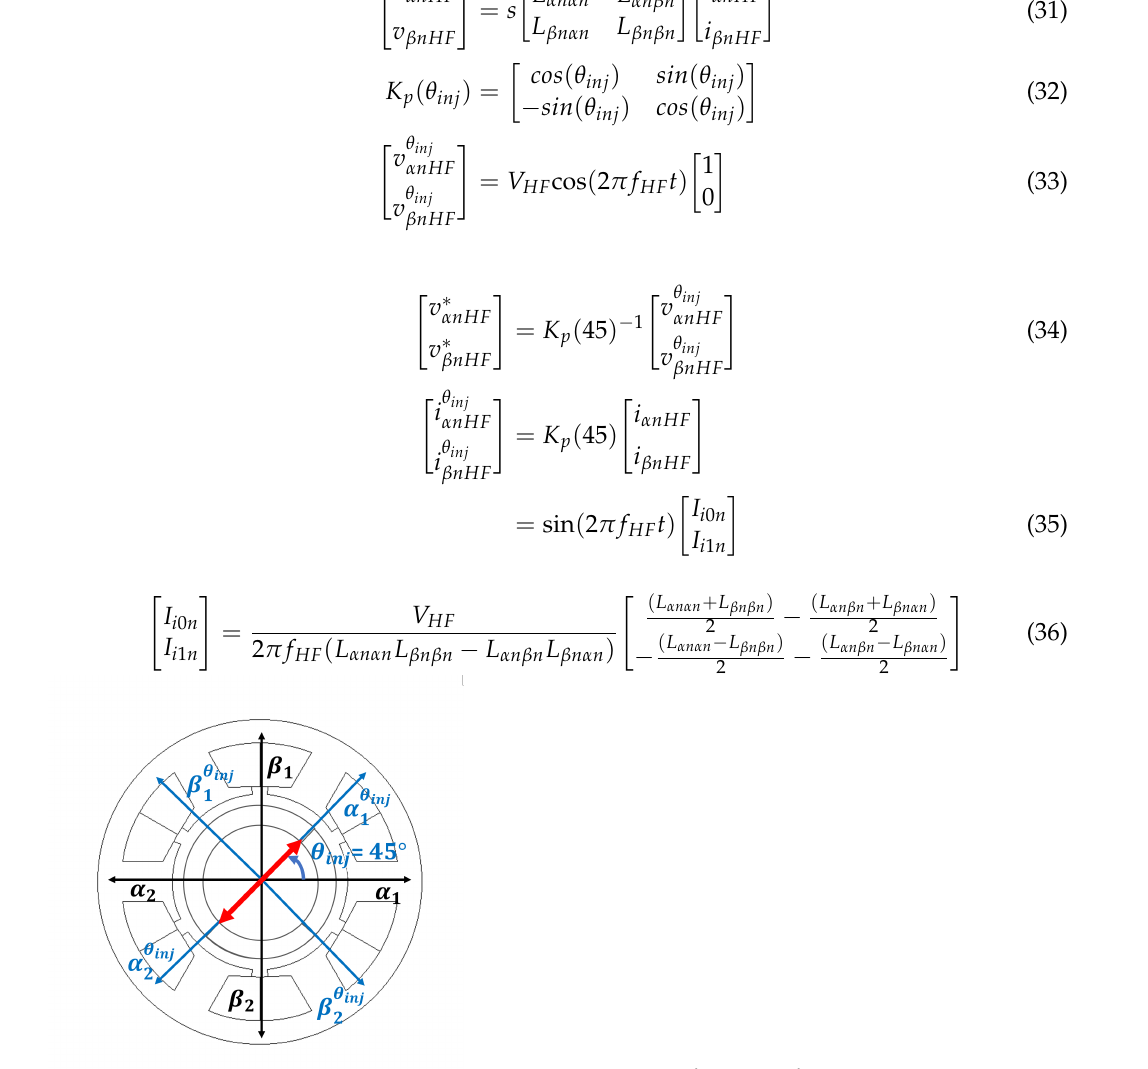
θ inj θ inj and αβ with θ inj , and stationary 2 1